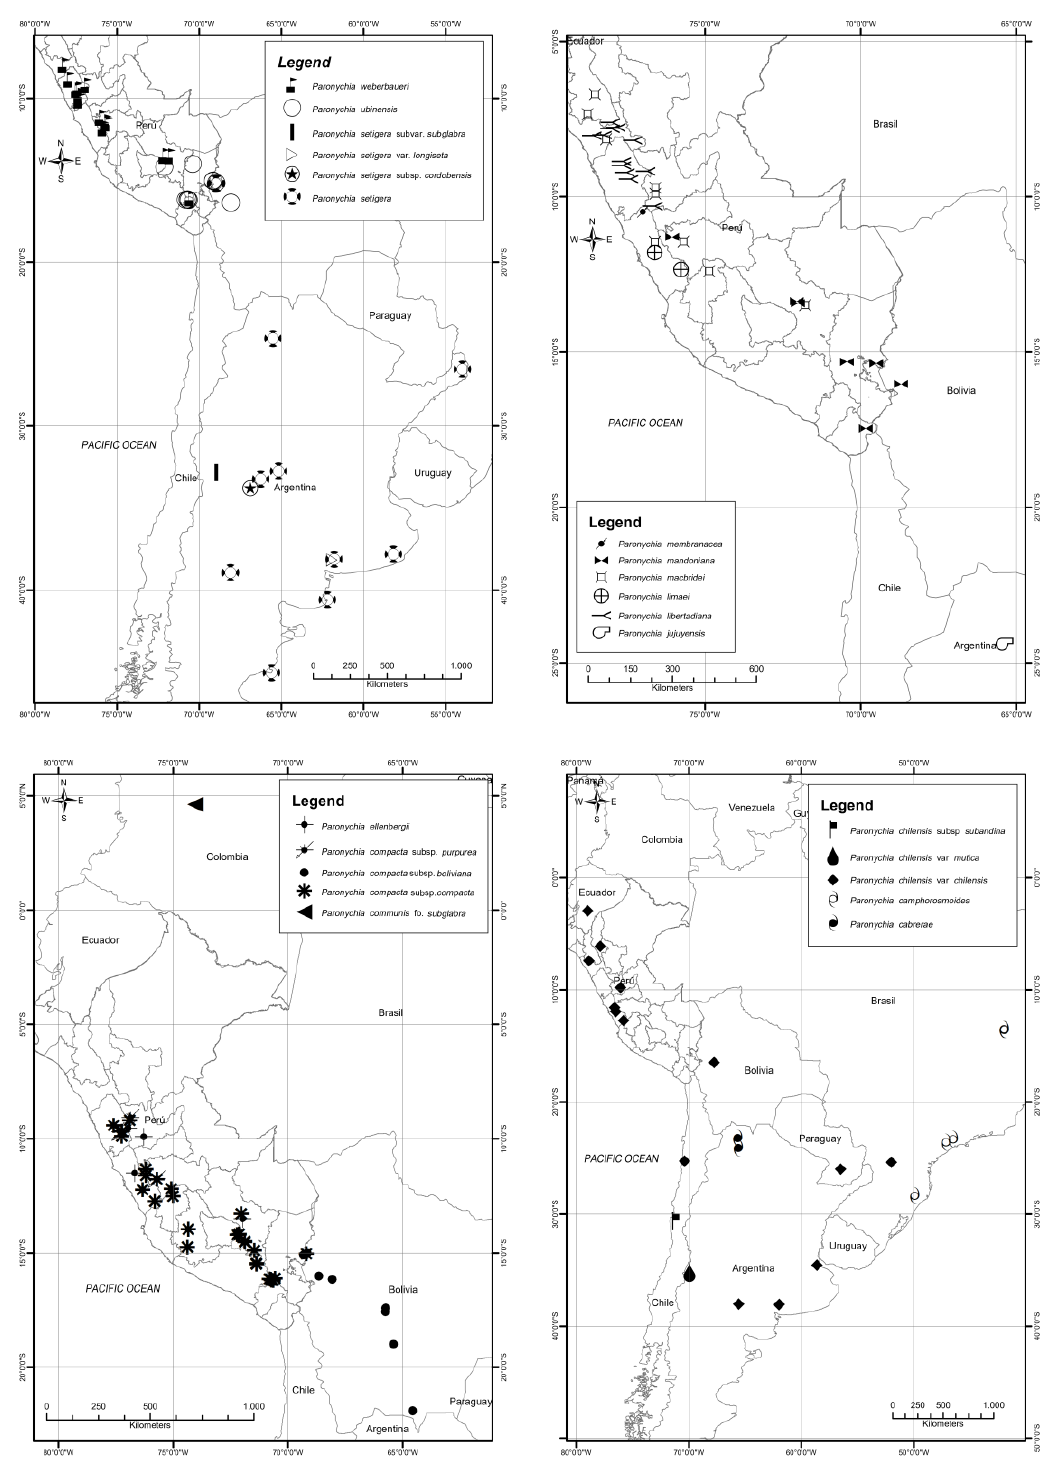
Figure 2/2. Distribution maps of Paronychia species occurring in South America. Figure 1. Distribution maps of Paronychia species occurring in South America. Taxonomic